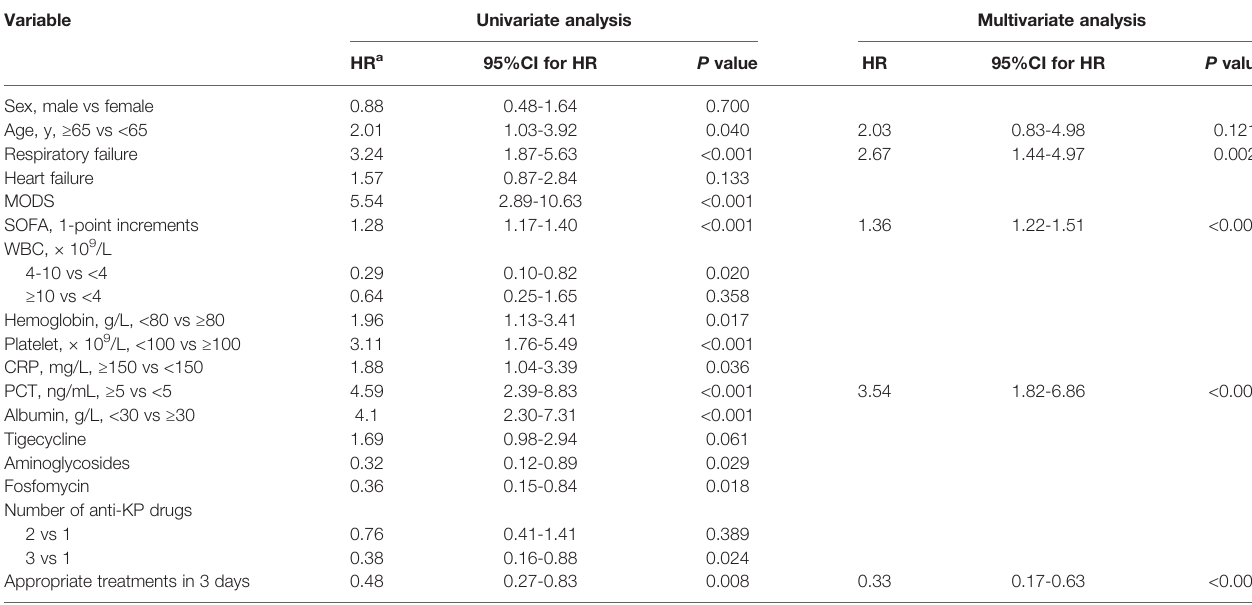
TABLE 2 | Univariate and multivariate Cox regression analysis of risk factors for 30-day mortality. Variable